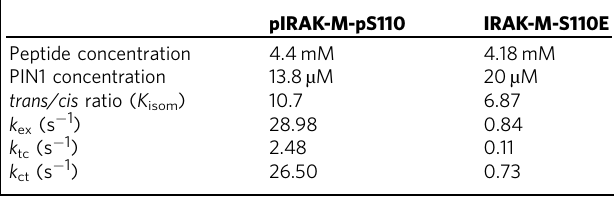
Fig. 3 PIN1 binds to and isomerizes the pS110-P111 motif, located C-terminal to the IRAK-M DD. a Binding of the PIN1 WW domain to IRAK-M-pS110 peptide is demonstrated by overlaid regions extracted from 1 H- 15 N HSQC spectra of 15 N-labeled PIN1 WW domain that show progressive peak shifts with increasing peptide concentration (apo = red, purple = highest concentration). b Changes in chemical shift ( Δ ω ) with increasing IRAK-M-pS110 peptide concentration ( fi lled circles) were fi t to a simple bimolecular interaction model (solid lines) to yield the apparent dissociation constant, App = 60.7 ± 11.5 µ M (mean ± s.d.). c PIN1 catalysis of IRAK-M-pS110 and IRAK-M-S110E peptides is demonstrated by ROESY spectra of each peptide in K D the presence or absence of PIN1. In the presence of PIN1 ( + PIN1, top two spectra), cross peaks between cis and trans appear for both IRAK-M-pS110 and IRAK-M-S110E peptides. In the absence of PIN1 (-PIN1, bottom two spectra), no cross peaks were observed for either peptide. d 1 H- 15 N HSQC spectrum of cleaved 15 N-IRAK-M[1 – 119:R56D,Y61E]. e Ribbon diagram of the IRAK-M DD structure determined by NMR, showing the six alpha helices and highlighting the Y105-L20 interaction that anchors the C-terminal tail to the structure. f A ClusPro generated model of IRAK-M DD docked into a modi fi ed Myddosome oligomer containing three IRAK1 DD subunits in the L, M and N positions in the 3MOP structure. Blue: six MyD88 DD subunits, Green: Four IRAK4 DD subunits, Cyan: three IRAK1 DD homology model subunits, Yellow: docked NMR structure of the IRAK-M DD. g – j Proposed model for IRAK-M and PIN1 regulation of IRAK1 mediated immunity signaling. g IRAK1 homotetramer assembled on the Myddosome is able to achieve full hyperphosphorylation through each IRAK1 unde fi ned domain (UD) being phosphorylated by neighboring IRAK1 kinase domains (KDs). h In the presence of IRAK-M, heterotetrameric IRAK-M/IRAK1 assembles on the Myddosome where IRAK-M DD replaces every-other IRAK1 DD subunit, preventing further IRAK1 hyper-phosphorylation and inhibiting IRAK1 release from the Myddosome thereby suppressing IRAK1-mediated in fl ammation. i IRAK1 KD phosphorylates